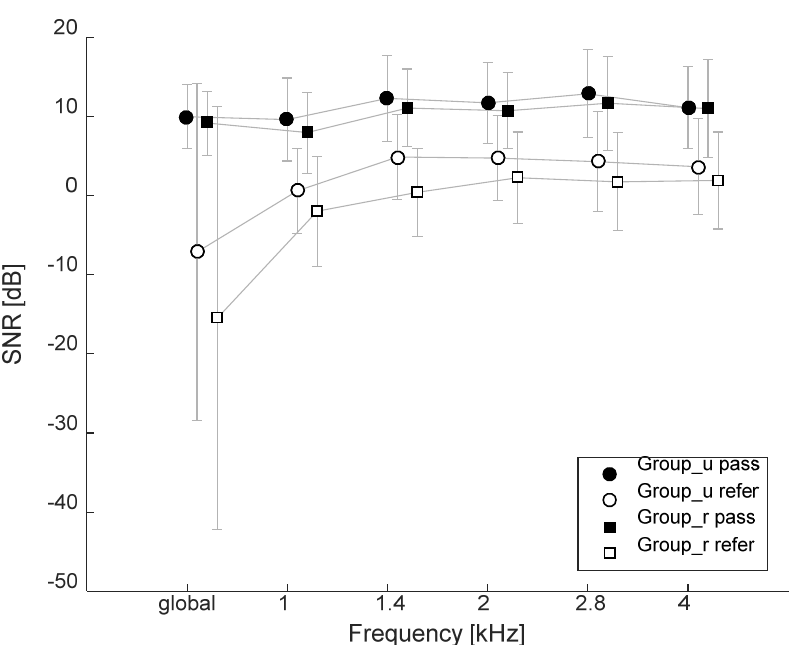
Figure 2. Average SNR values for TEOAE results for Group_u (urban) and Group_r (rural), broken down into those that met the OAE presence criteria (pass) and those that did not (refer). Data are shown for global (global = SNR for the whole broadband TEOAE signal) as well as for half-octave frequency bands.